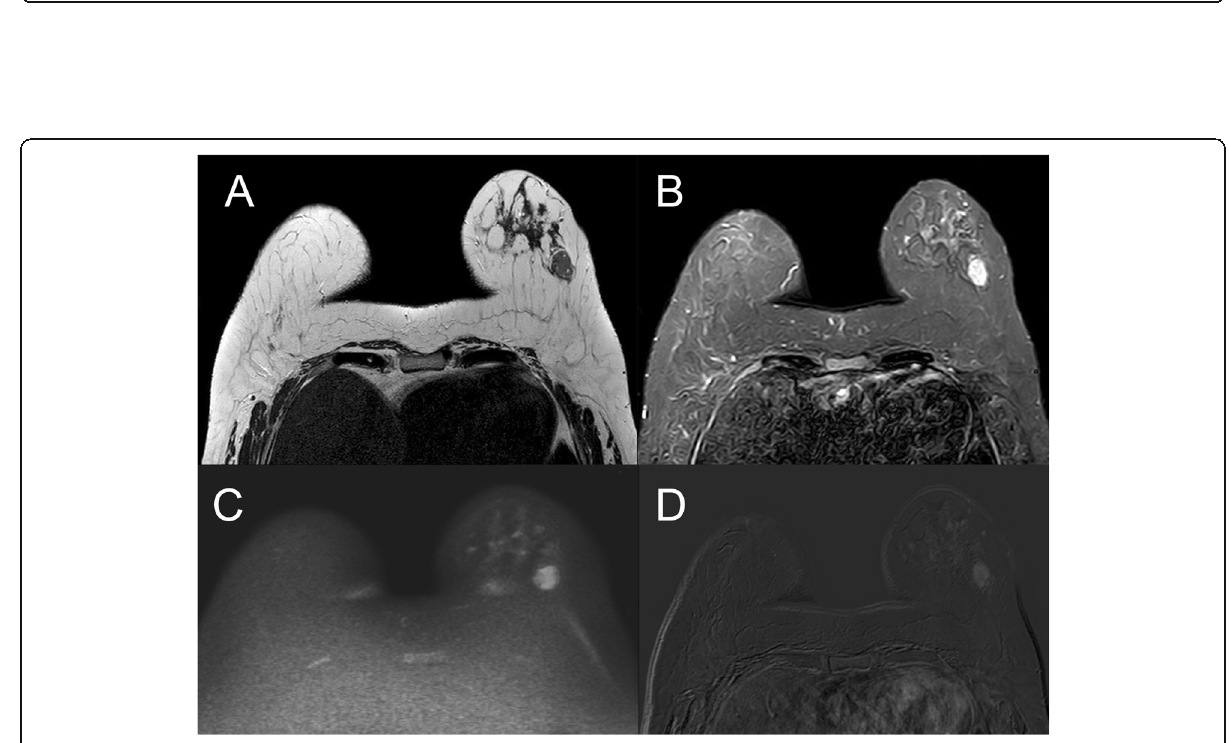
Fig. 4 A well-defined mass lesion was noted in left breast. It was of intermediate SI in T2WI ( a ), high in STIR ( b ), mildly restricted in DWI, with homogenous enhancement ( e ), and plateau-type kinetic curve in DCE-MRI. Yet, histopathology revealed it was invasive duct